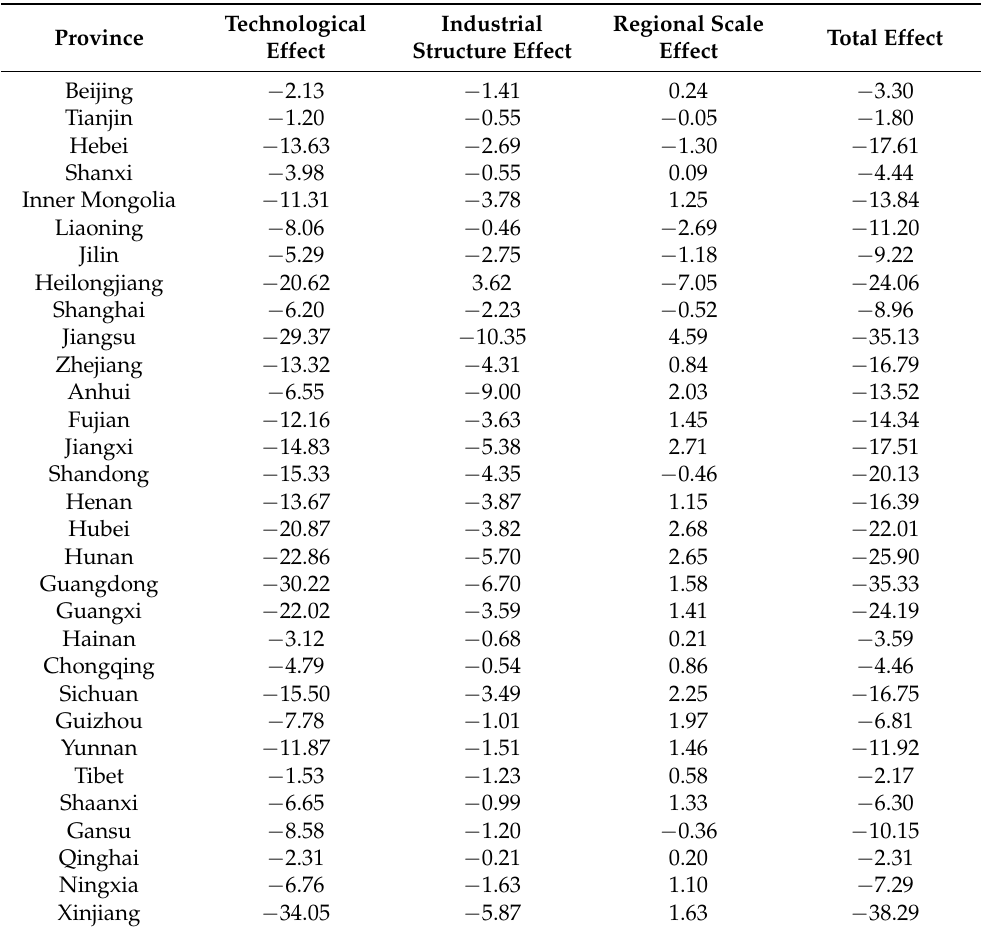
Table 2. Three effects in each province in